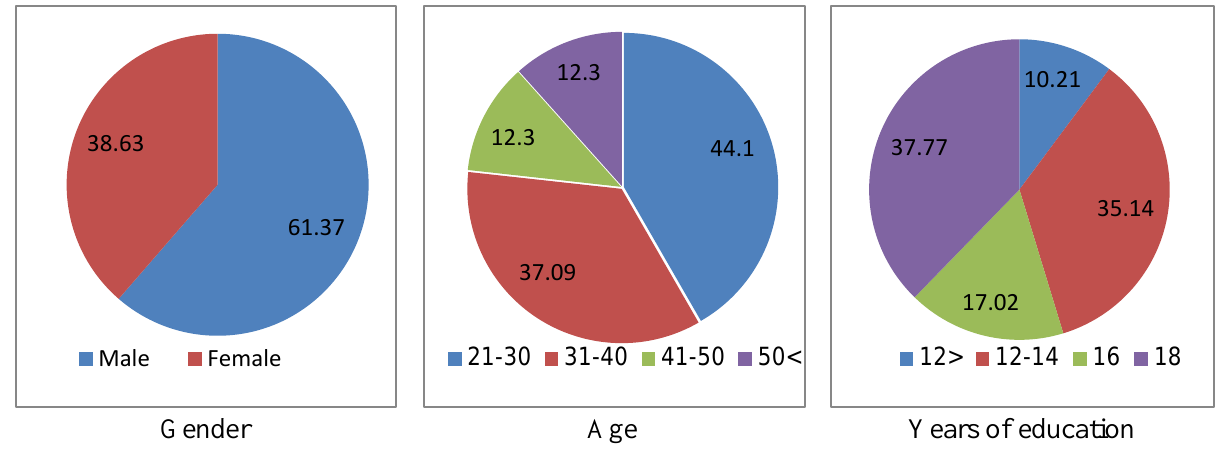
Fig. 2. Personal characteristics of the participants